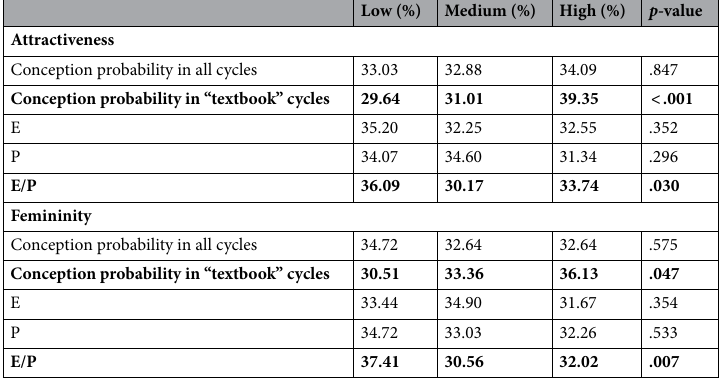
Table 1. Proportion of choices for each judgement, including attractiveness and femininity choices for each of the five fertility cues in the 3AFC task (non-random choices in